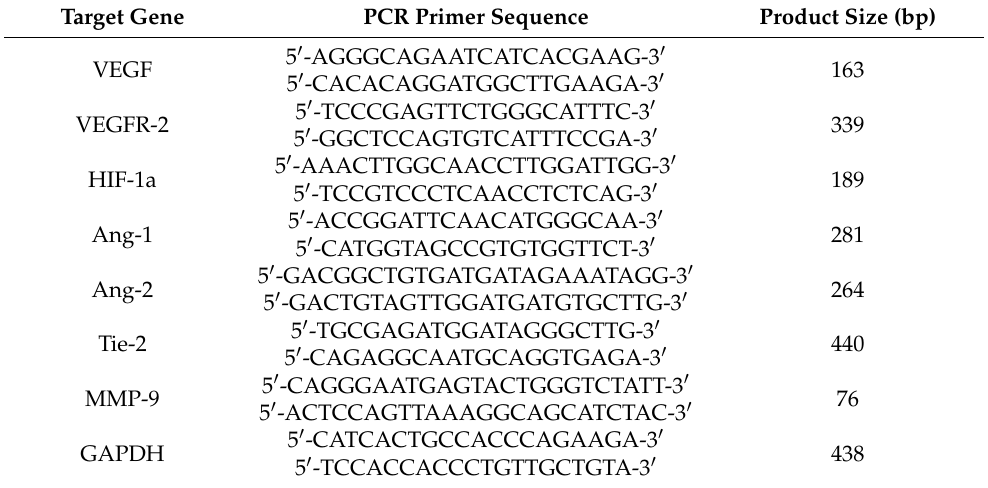
Table 2. The sequence of the specific sets of primers used in RT-PCR